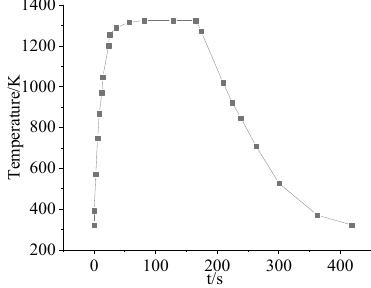
Figure 5. Interface temperature of the TBC in a single cycle [13]. Table 5. Test results of the thermal fatigue experiment under a preheating temperature of 1323 K [14]. Cycle Number Preheating Time, Test Condition